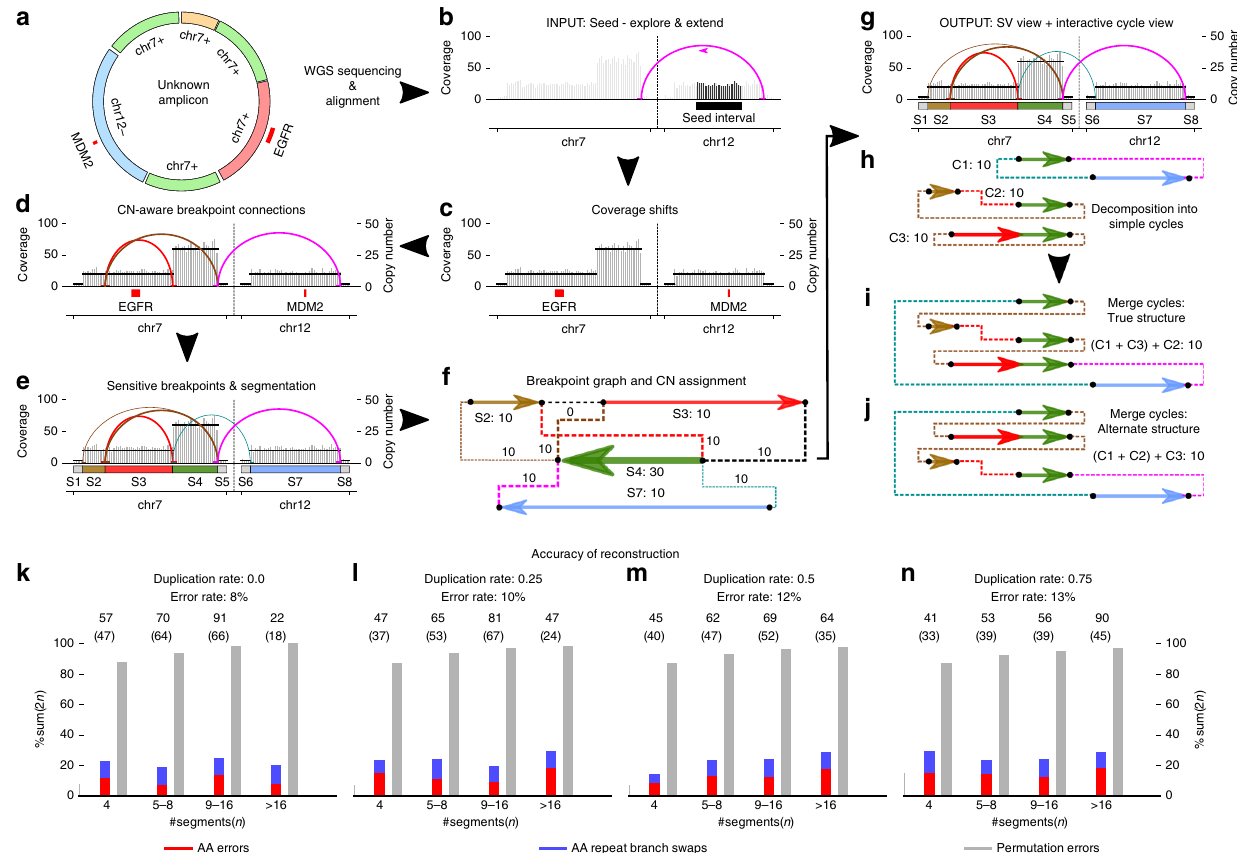
Fig. 1 Schematic of AmpliconArchitect (AA). AA takes as input: a aligned whole-genome sequencing data from a sample with an amplicon, and b a seed interval from the amplicon. It automatically searches for and identi fi es other intervals that are part of the same amplicon; c Next, AA identi fi es breakpoints by segmenting intervals at positions with a sharp change in copy number, or d containing a cluster of discordant paired-end reads. Finally, e AA re fi nes breakpoint locations and partitions the intervals into smaller segments. f The collection of segments and breakpoints is used to generate a breakpoint graph and a balanced fl ow approach is used to re fi ne segment copy numbers. Arrows represent the orientation of a segment from lower to higher coordinate. g , h The entire graph describes a breakpoint signature and a succinct “ SV view ” of the amplicon, which is also decomposed into short basis cycles in the “ Cycle view ” . See Supplementary Figure 1 for detailed description. i , j Alternative merging of the short cycles with overlapping segments can generate multiple amplicon architectures consistent with the short-read data. k – n Amplicon reconstruction on a variety of simulations showed high fi delity of reconstruction (red bar, 11% error) relative to a random “ permutation predictor ” (gray bar, 85% error). Swaps (blue bars) represent cases with alternative structures supported by the data. Numbers above each bin represent total number of simulations in the bin and numbers in parenthesis represent number of simulations reconstructed without errors. Source data are provided as a Source Data fi